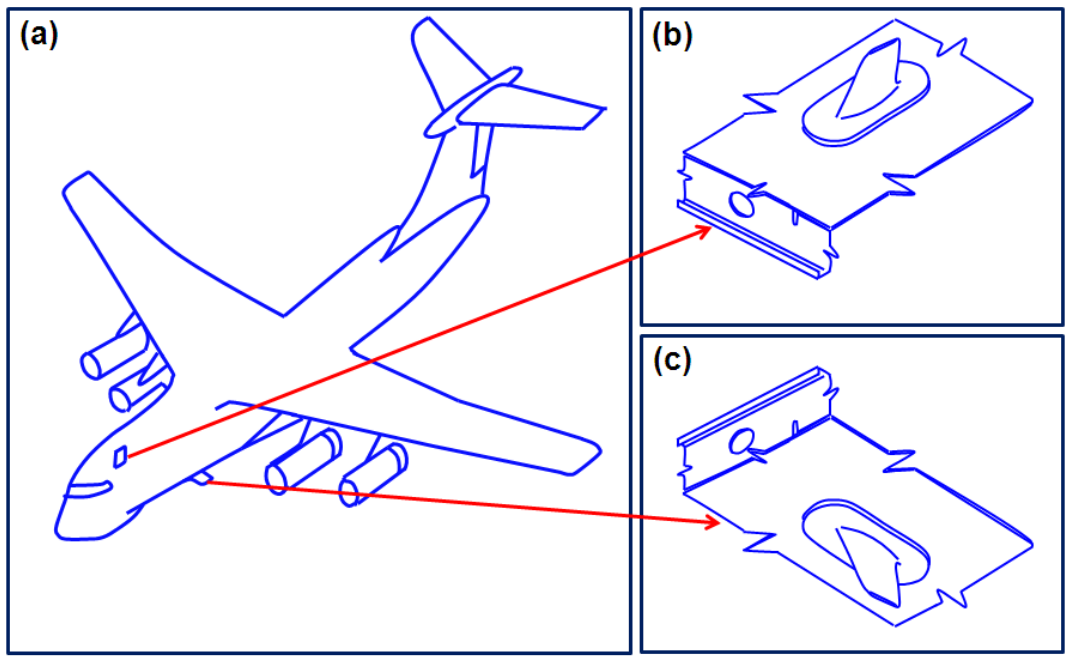
Figure 2: Schematic diagrams of: (a) aircraft; (b) top and (c) bottom